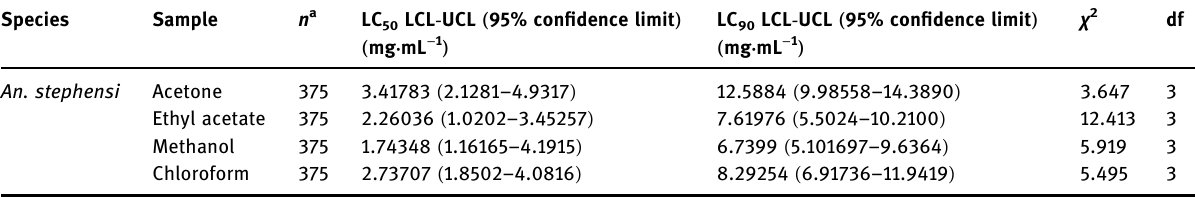
Table 3: Larvicidal activity of C. baccifera leaf extracts against fourth instar larvae of An. stephensi Species